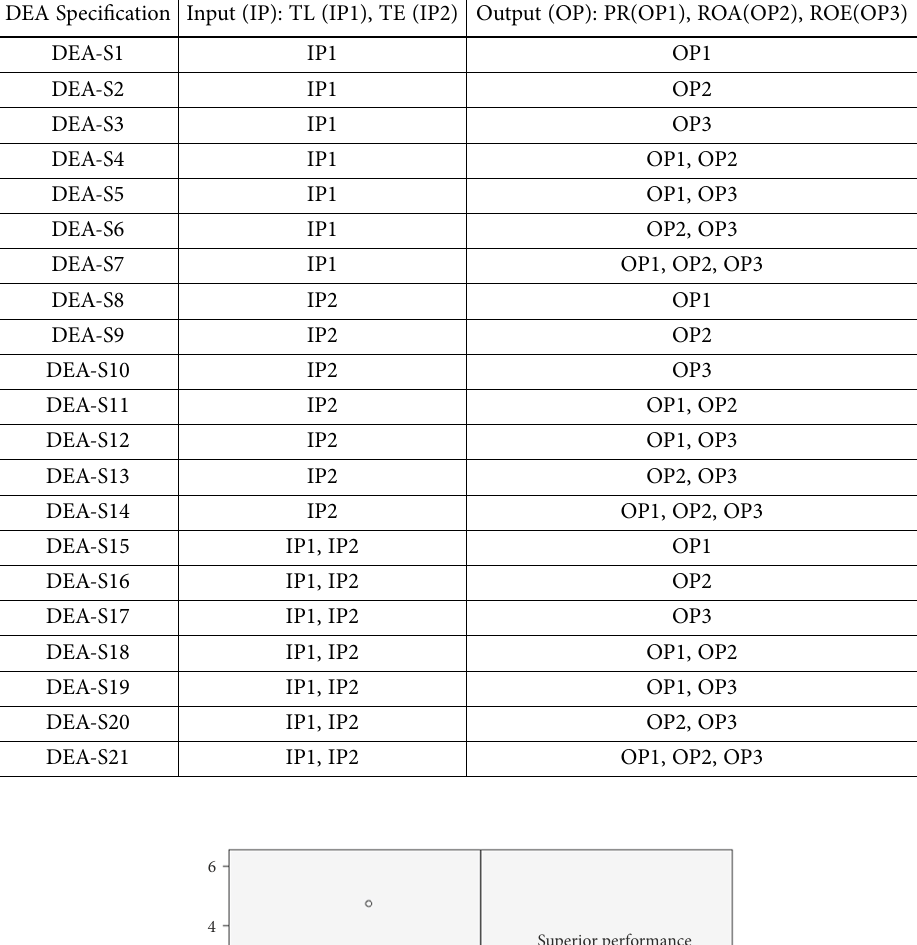
Table 2. Multiple DEA specifications